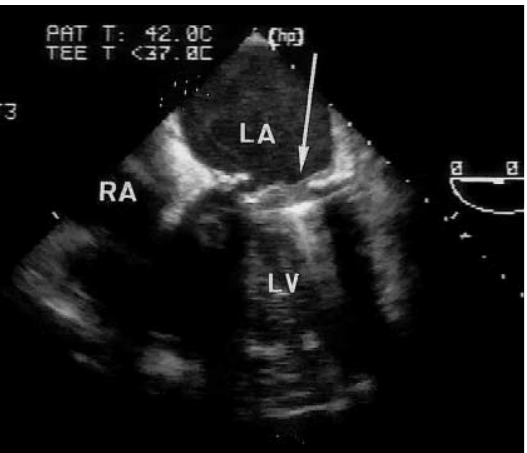
Transoesophageal echocardiography in patient #8 shows tissue covering the bileaflet mitral valve, with one leaflet com- pletely immobilised and one partially. In- traoperatively, pan- nus and thrombus completely covering the prosthetic mitral valve and extending far into the left ventricle were found. LA = left atrium; LV = left ventricle; RA = right atrium.